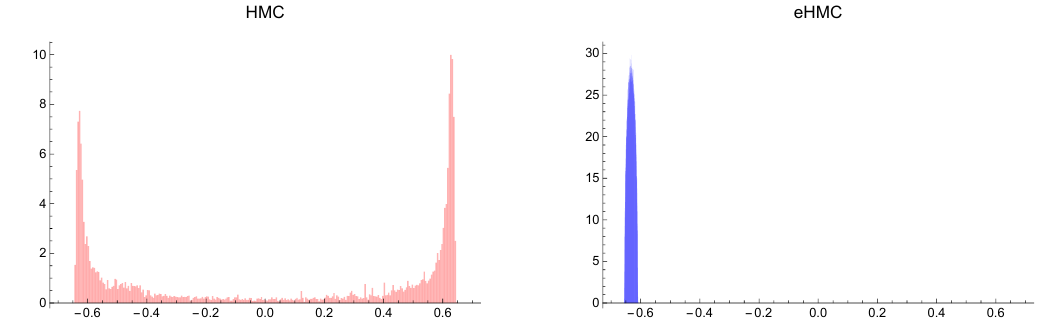
Figure 5 . Eigenvalue distribution for first approximately 10 3 configurations, with thermalisation steps dropped, of the fuzzy sphere model (5.1) with N = 100 , b = − 400 and c = 500 . From previous studies [8], it is known that the asymmetric (with respect to the zero value) configuration is thermodynamically preferred and it has been obtained quickly using eHMC method. The system was initialised from a random configuration in which the eigenvalues are distributed randomly between negative and positive